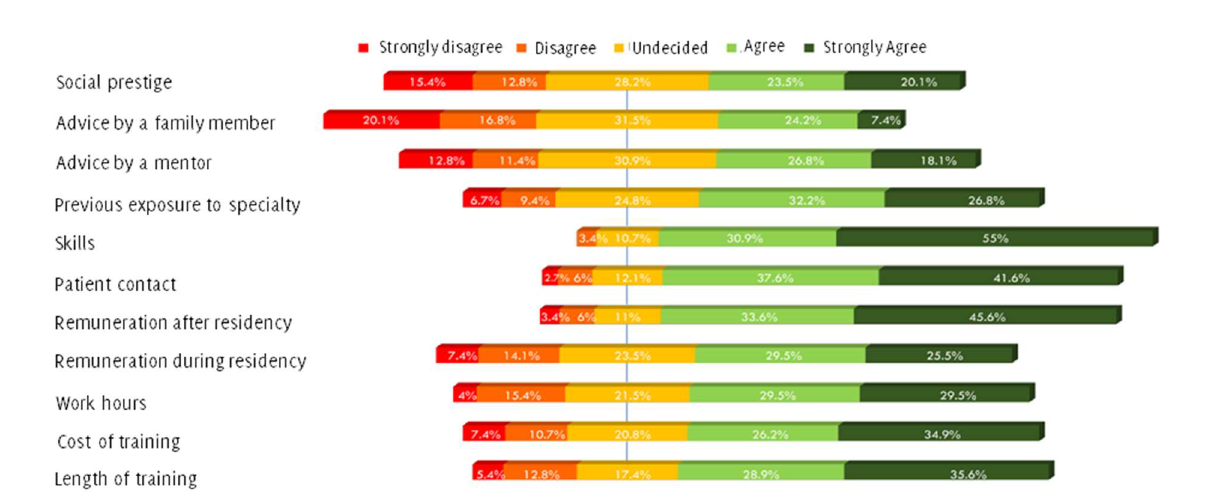
Figure 2 . Factors Influencing the Choice of a Specialty and the Level of Agreement of Sixth- and Seventh Year Medical Students.